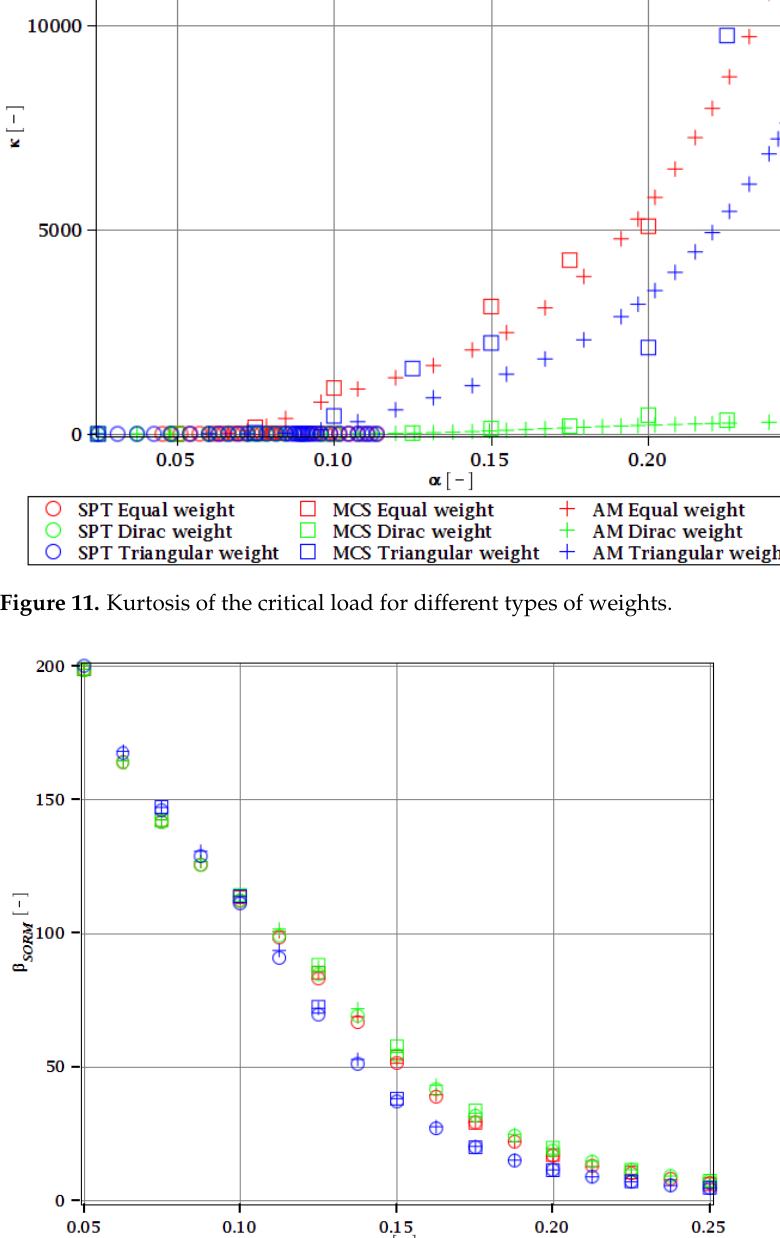
Figure 12. Reliability index of the corrugated I-beam for different types of weights according to the second-order reliability method (SORM) — displacement.